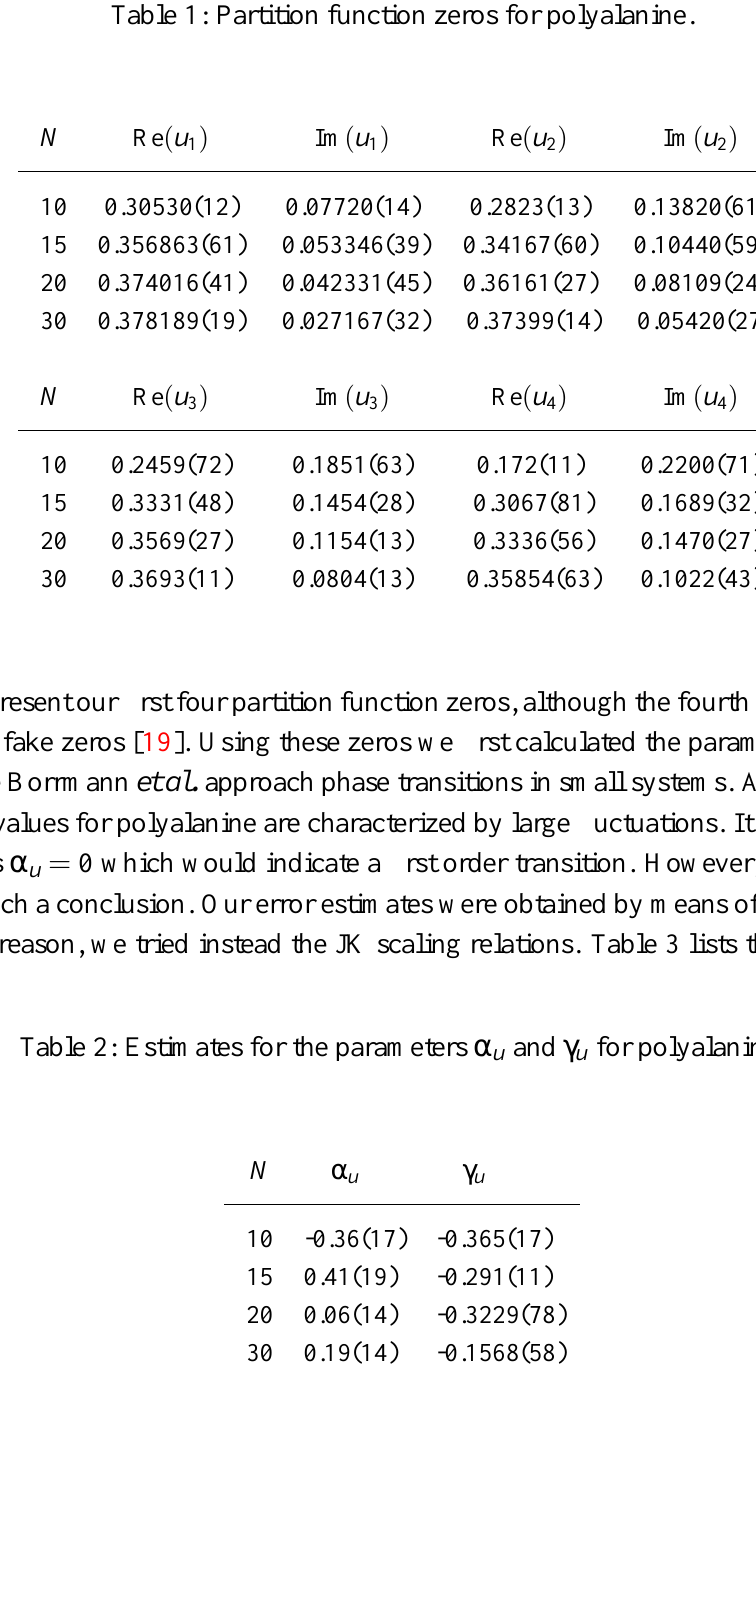
Table 1: Partition function zeros for polyalanine.